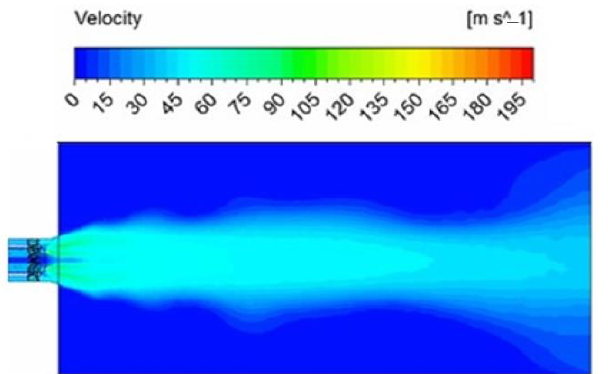
Figure 8. Building a mathematical model of the velocity distribution based on the data collected by the neural network.